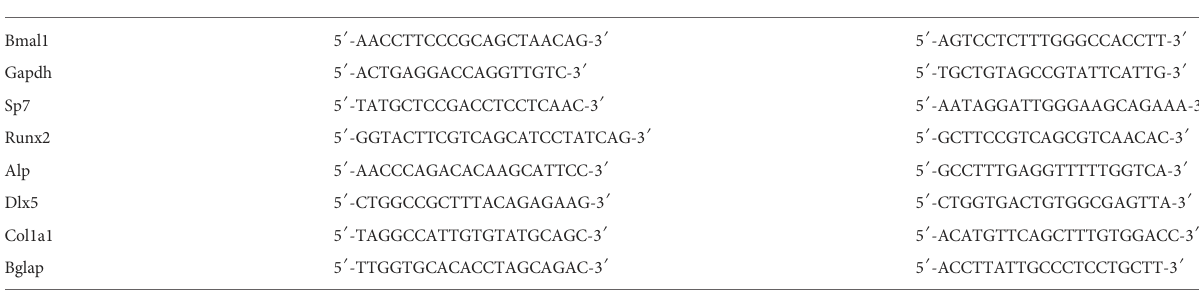
TABLE 1 Primer sequences for